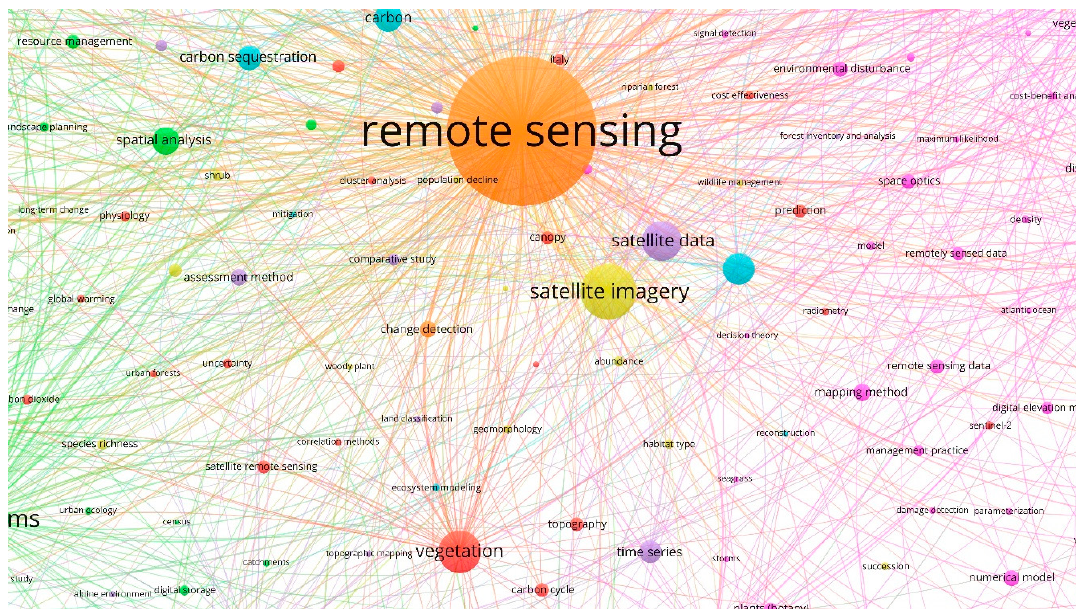
Figure 5. Links of “Remote Sensing” keyword (1976–2019).